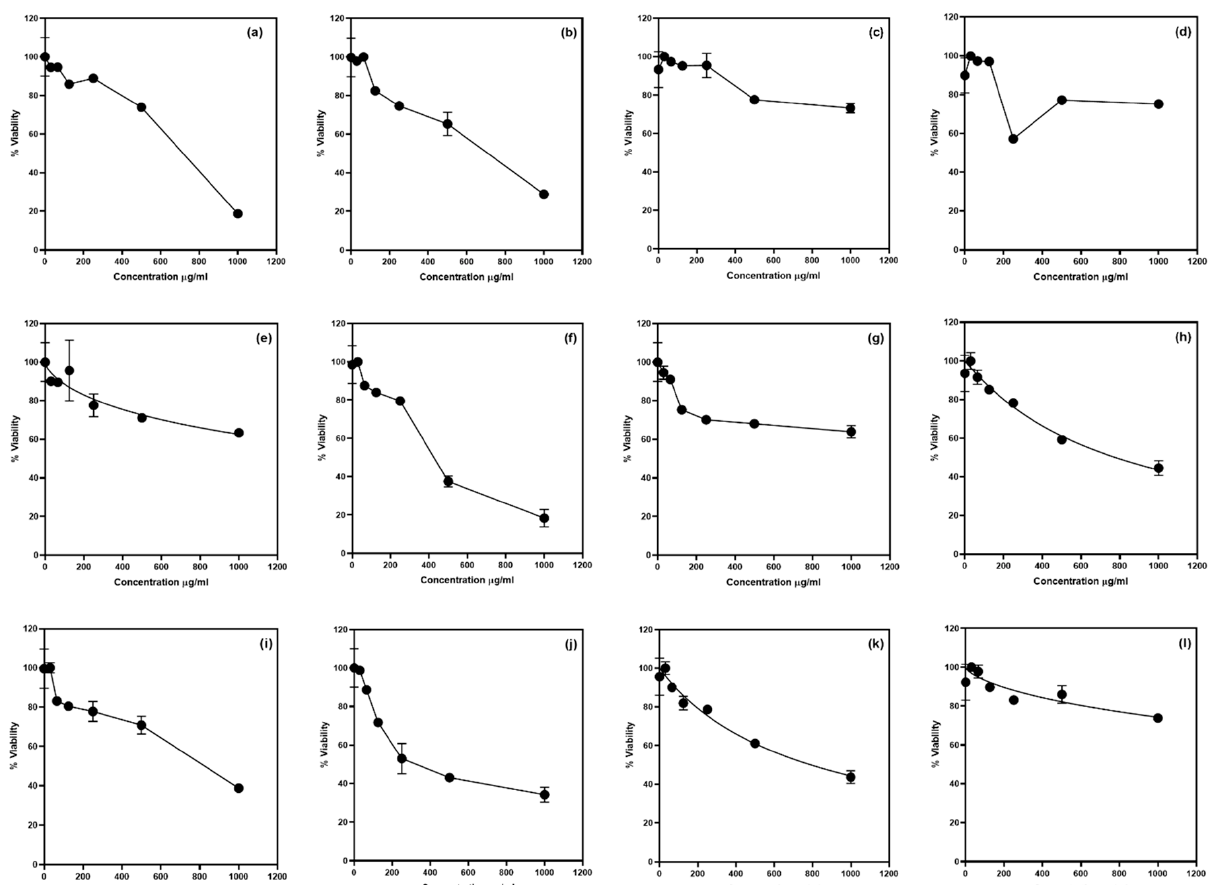
Figure 5. Graphical representation of cell viability percentage of different M. peregrina extracts on 3T3- L1 with 72 h incubation: ( a )—Hexane extract (Tubers); ( b )—chloroform extract (tubers); ( c )—acetone extract (tubers); ( d )—methanol extract (tubers); ( e )—hexane extract (leaves); ( f )—chloroform extract (leaves); ( g )—acetone extract (leaves); ( h )—methanol extract (leaves); ( i )—hexane extract (stem); ( j )—chloroform extract (stem); ( k )—acetone extract (stem); ( l )—methanol extract (stem). Values were expressed as mean ± SD of three experiments ( p -value relative to control group: p <